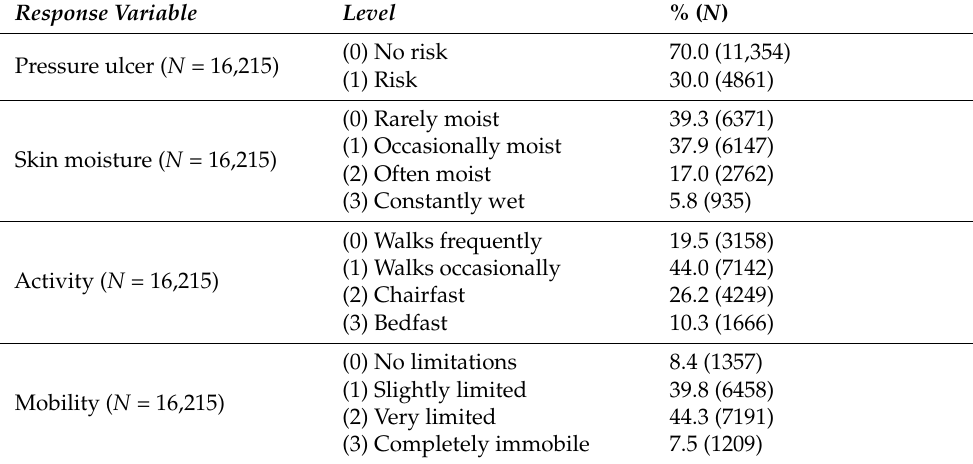
Table 1. Description of